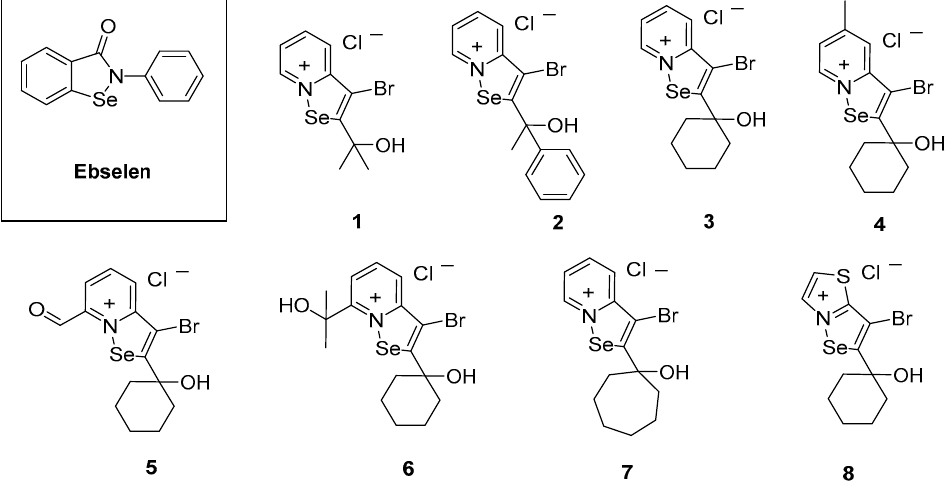
Figure 1. Chemical structures of ebselen (in the insert) and the selenazolinium salts 1 – 8 investigated.